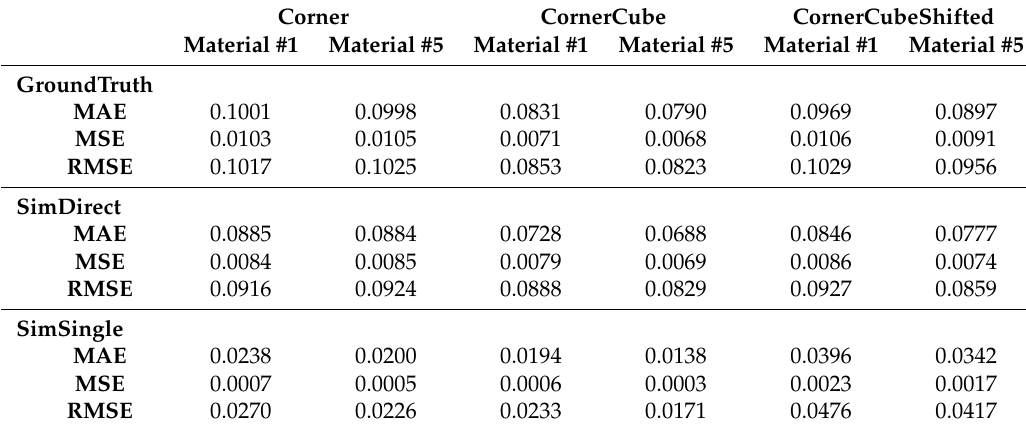
Table 2. Evaluation of error for all simulation methods and scenes with respect to to the measured CamCube data. For each method you can see the the mean-absolute-error ( MAE ), mean-squared-error, ( MSE ) and the root-mean-squared-error ( RSME